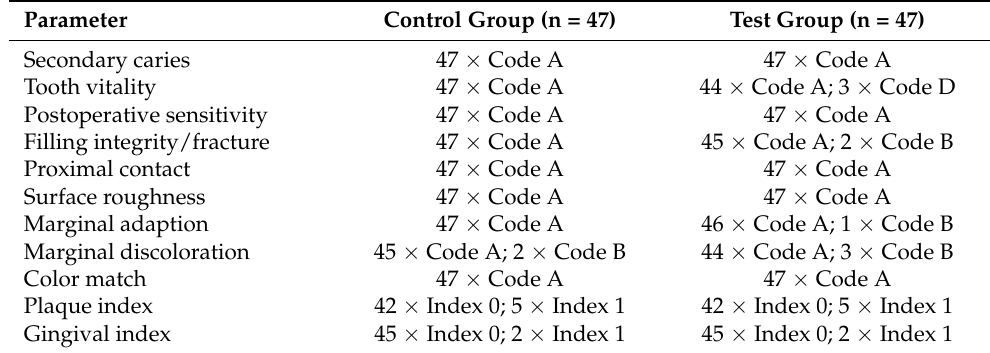
Table 4. Summary of evaluated parameters (A = Alpha, B = Bravo, C = Charlie, and D = Delta).